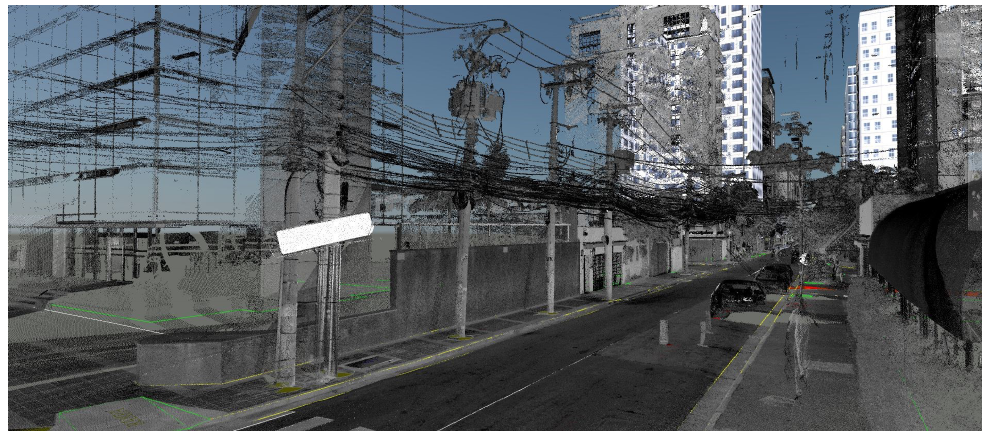
Figure 9. Example of MMS System output.